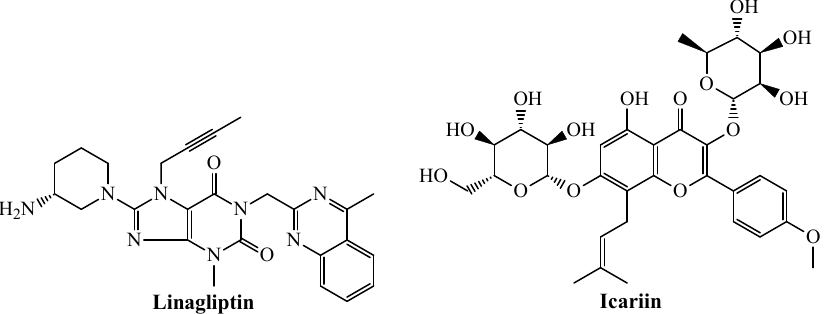
Figure 5. Some of the top-ranked drug/agency-regulated chemicals predicted as dual inhibitors of caspase-1 and TNF-alpha inhibitors. caspase-1 and TNF-alpha